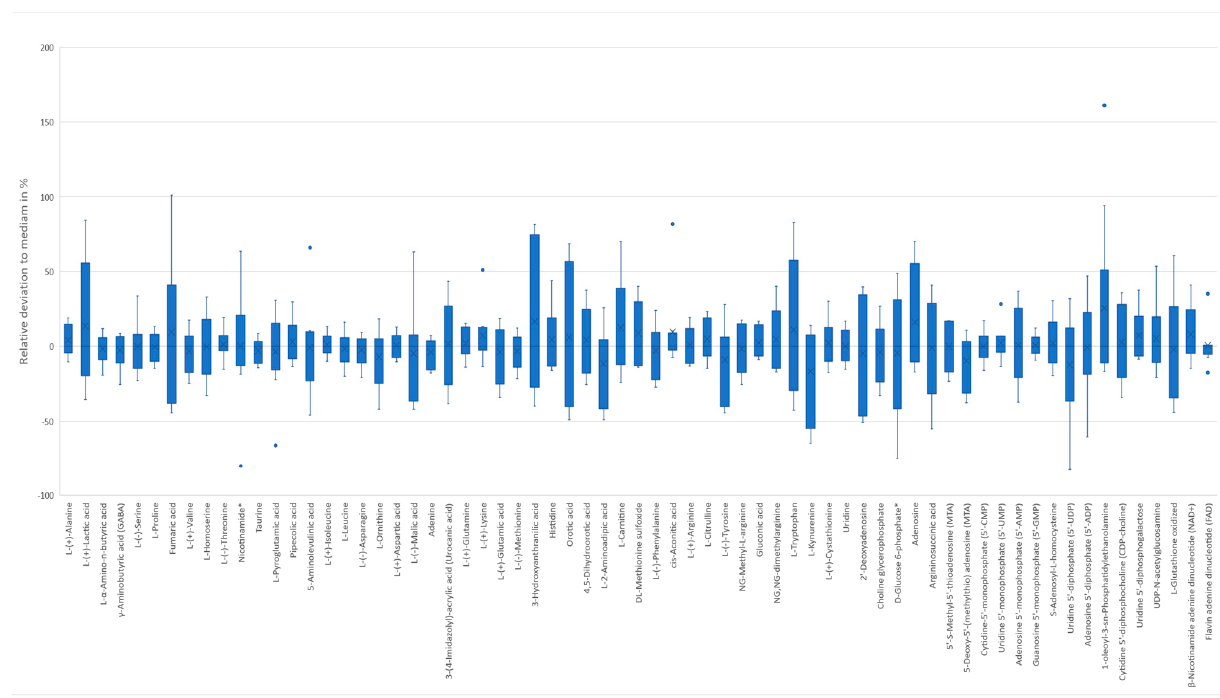
Figure A4. Relative deviation of all the samples to the median sample area of the 67 most stable compounds (more information on the stable metabolites can be found in Supplementary Table S1, BC-filtered ratio). Addition of (+) and (-) indicates the polarity of measured compounds, if no labeling is assigned, both modes can be used.